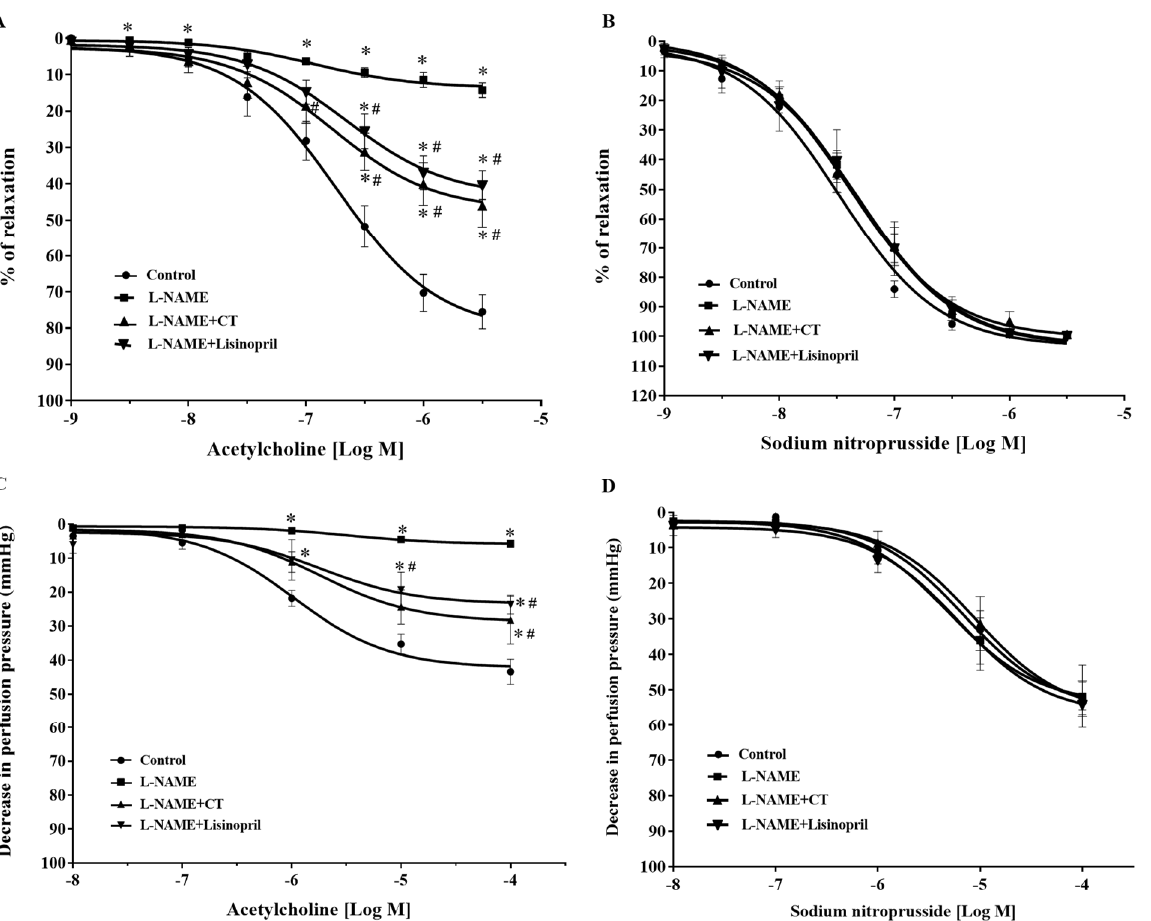
Figure 2. Effects of CT extract and lisinopril on vascular function in thoracic aorta ( A,B ) and mesenteric vascular beds ( C,D ) in all groups of the experiment. Data are expressed as mean ± SEM ( n = 8/group), * p < 0.05 vs. control, # p < 0.05 vs. L-NAME, CT: Clitoria ternatea Linn. extract.